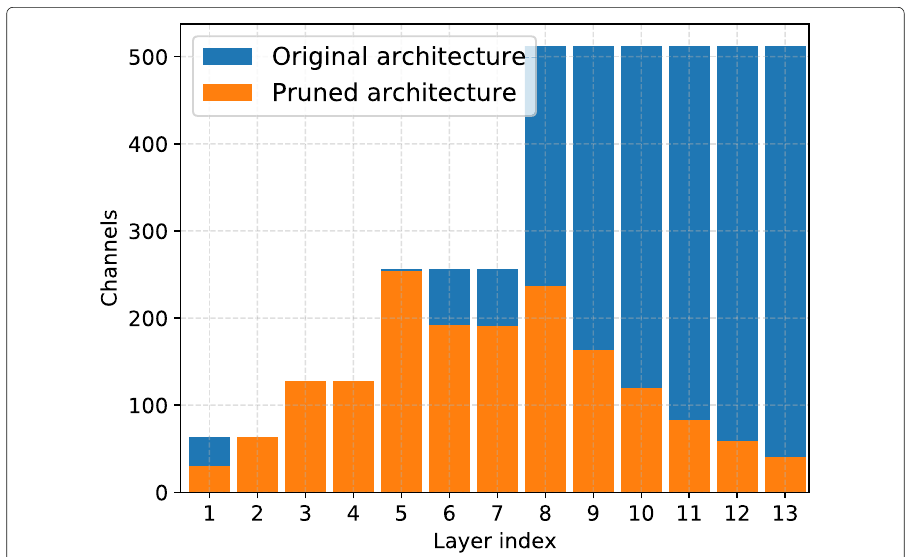
Fig. 9 Channel distribution of the pruned VGG on CIFAR-10. The abscissa indicates the indices of layers and the ordinate indicates the number of reserved channels